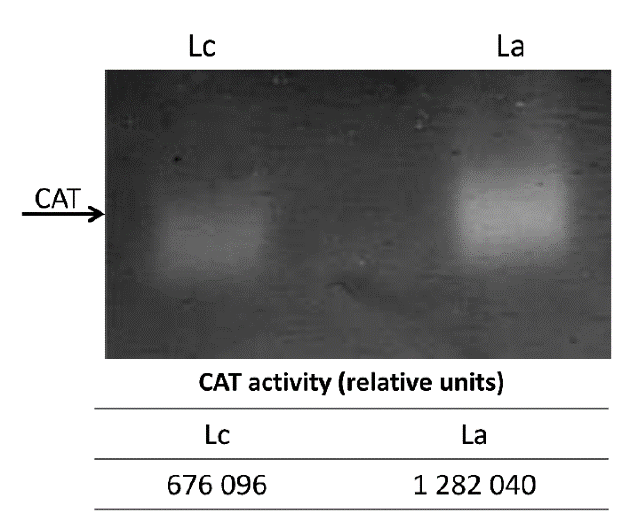
Figure 4. CAT activity was determined using 8% native gel in leaves of control and ash-growing plants. CAT activity, obtained by densitometry after analysis of gels in the program TotaLab, was presented in the table below the gel. Lc − control leaf; La − ash leaf.